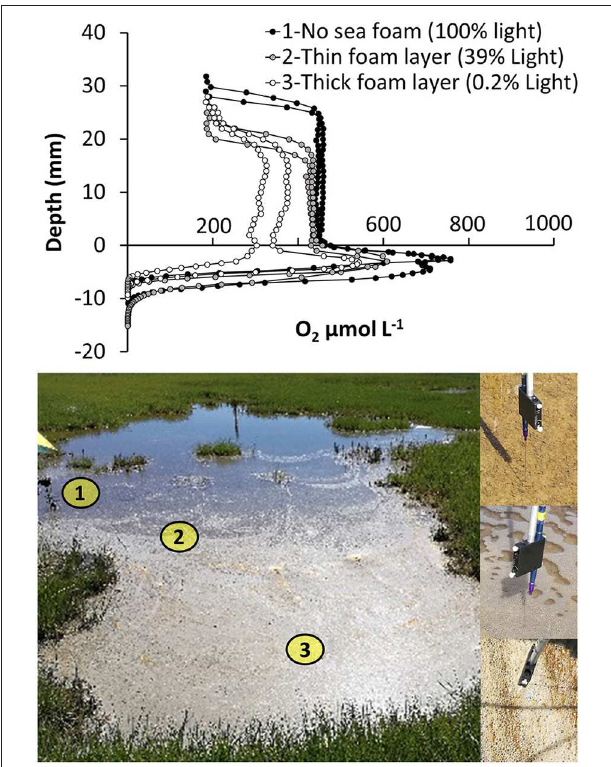
FIGURE 7 | Spatial variations in oxygen distribution within a salt marsh tidal pond. Oxygen profiles were measured at three locations with increasing thickness of sea foam and variable light penetrability: (1) no sea foam (65,000 ± 1,000 lux − 100% light penetration) (2) a thin seafoam layer (26,000 ± 9,000 lux − 39% light penetration), and (3) a thick seafoam layer (150 ± 75 lux − 0.2% light penetration).